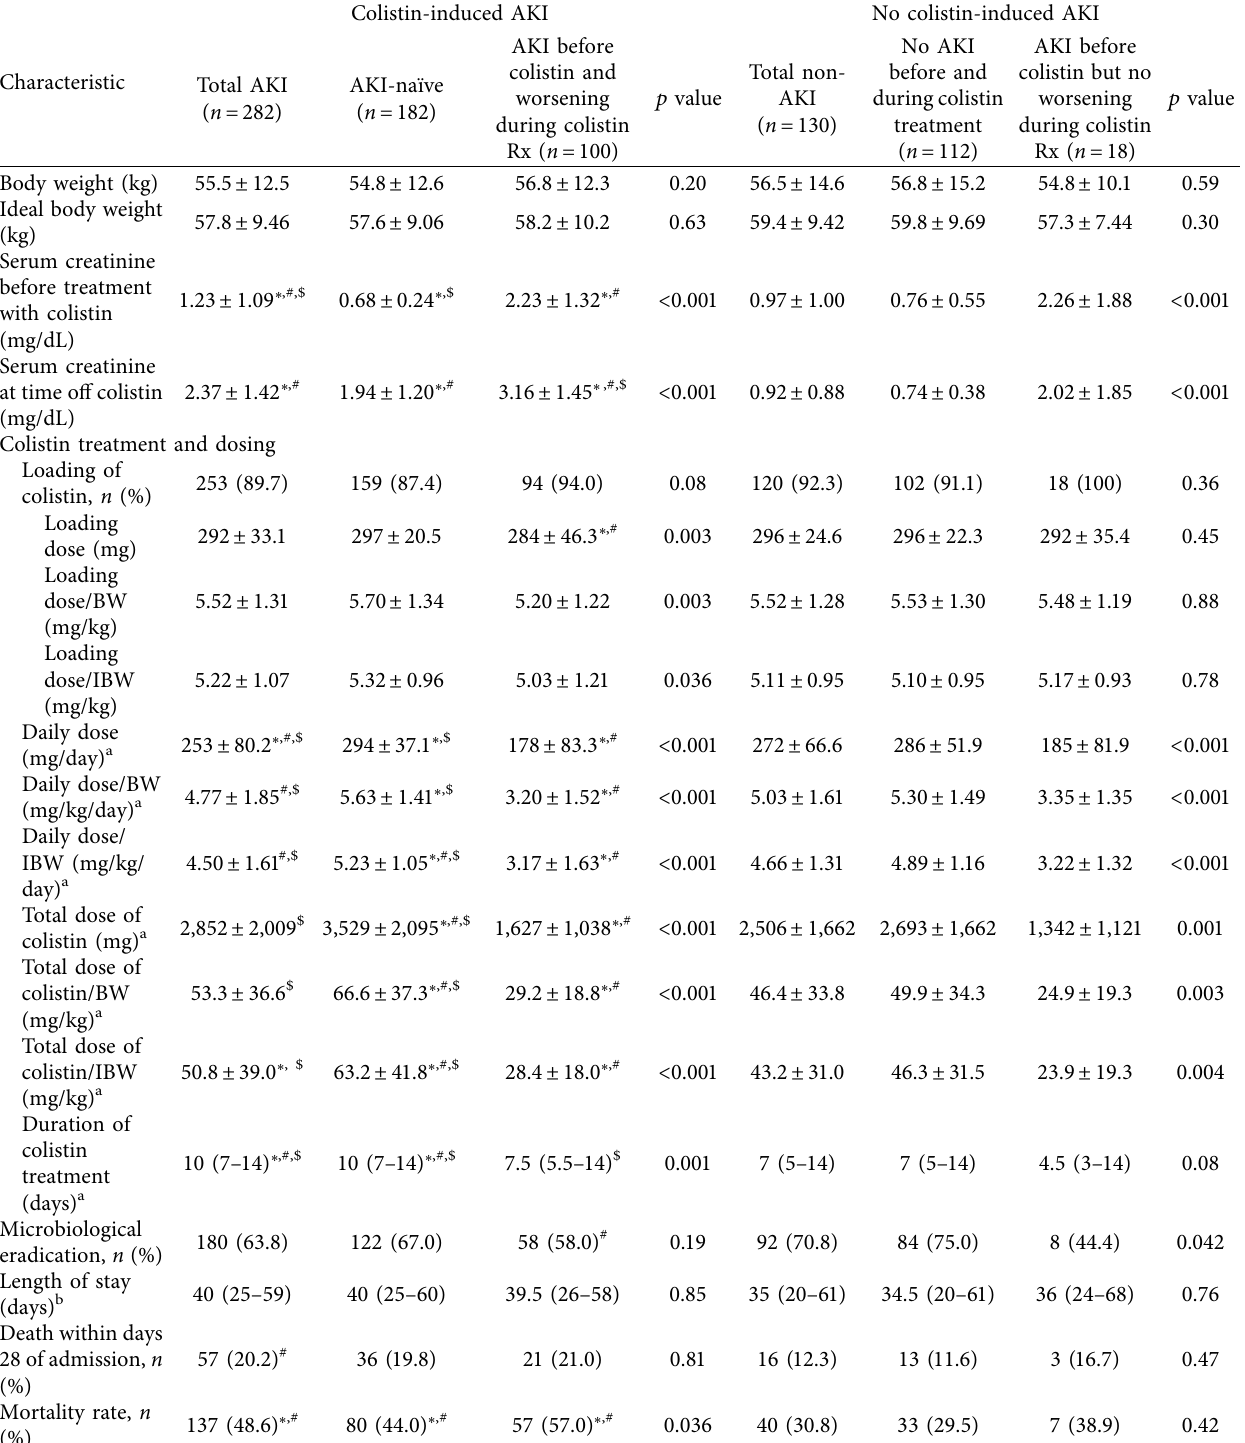
Table 4: Comparison of colistin dosage, length of hospital stay, and death outcomes between AKI and non-AKI groups.